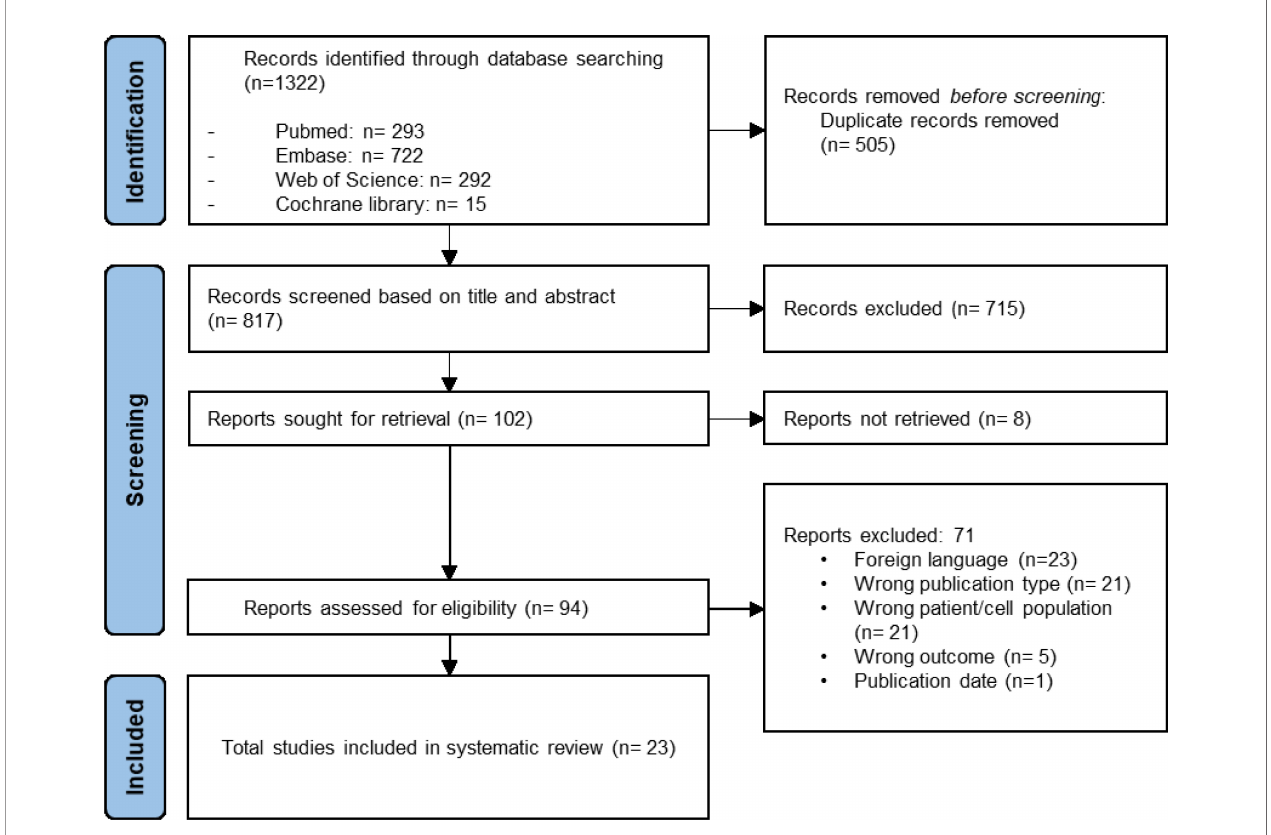
FIGURE 1 | Prisma fl owchart illustrating the selection of